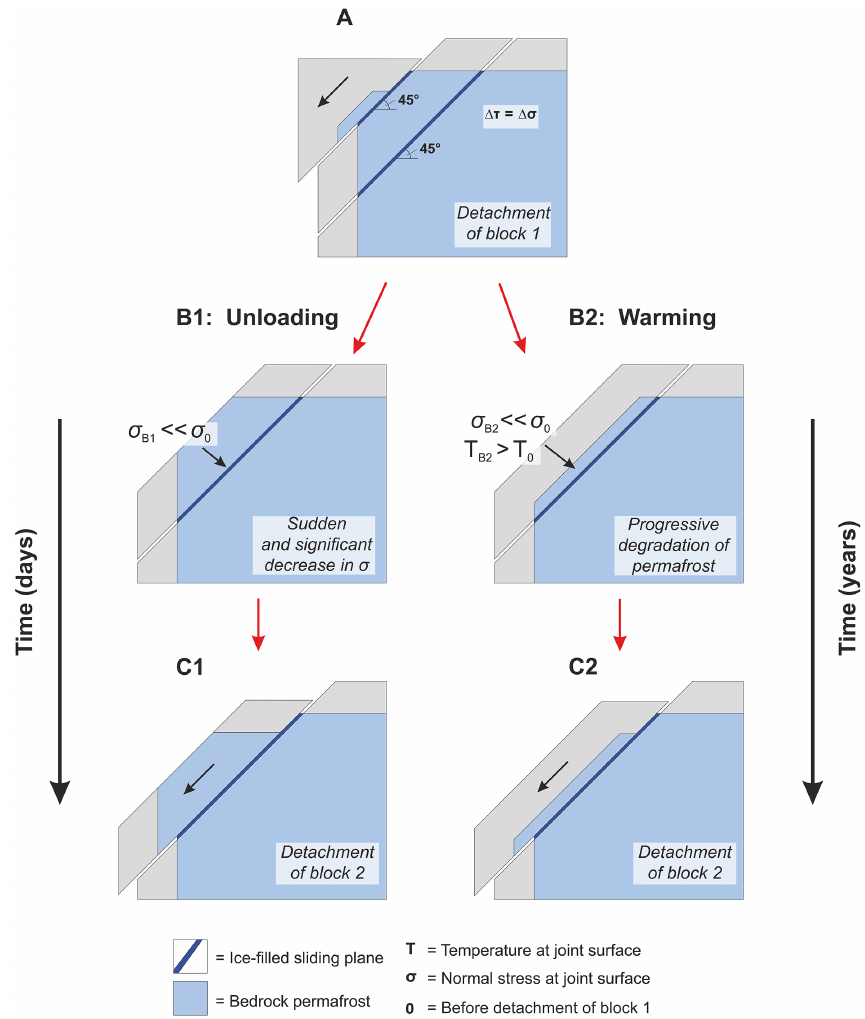
Figure 10. Progressive failure in a warming permafrost rock slope displaying thermal and normal stress conditions before and after de- tachment of a first slab. Both can initiate failure: (B2) progressive thermal warming (i.e. permafrost degradation) occurs within years, but (B1) sudden unloading develops even faster within